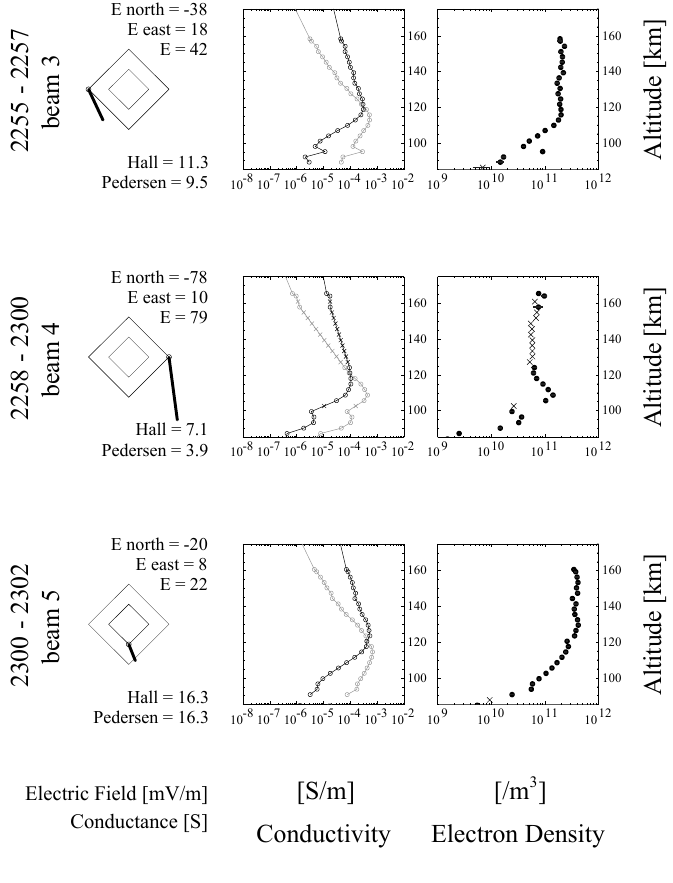
Fig. 10. EISCAT radar measurements of the altitude profile of the Pedersen (thick line) and Hall (thin line) conduc- tivities and the electron density, around the time when a dark spot was